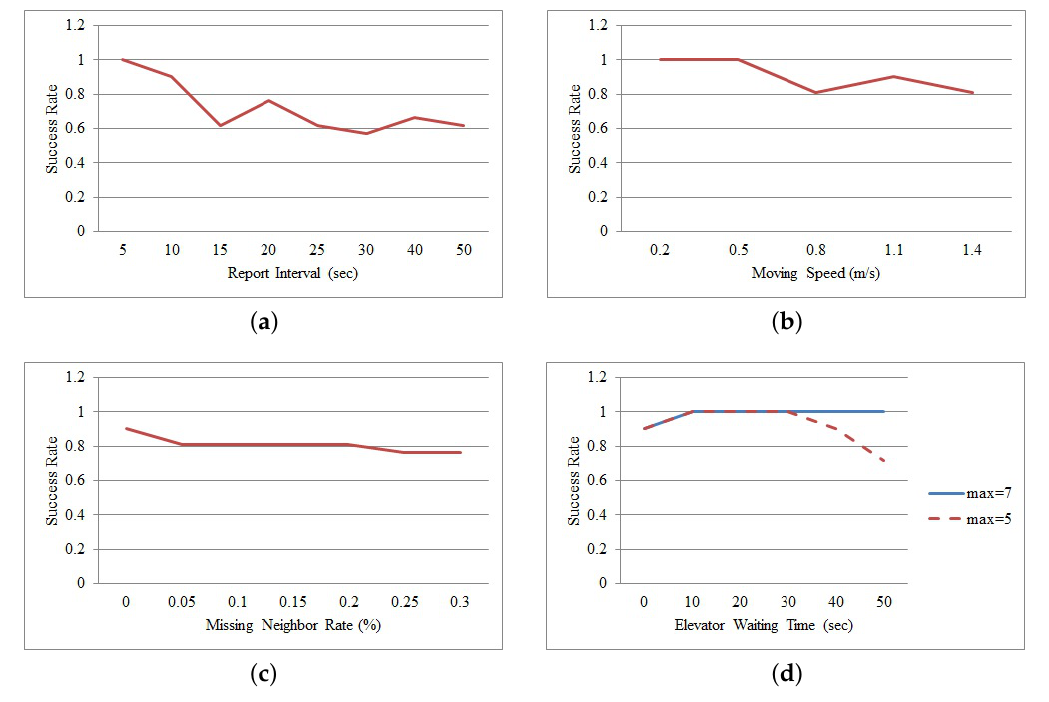
Figure 6. Detection results of both failed and left nodes in a real deployment model according to the parameter changes. ( a ) Report interval; ( b ) Moving speed; ( c ) Missing neighbor rate; ( d ) Elevator waiting